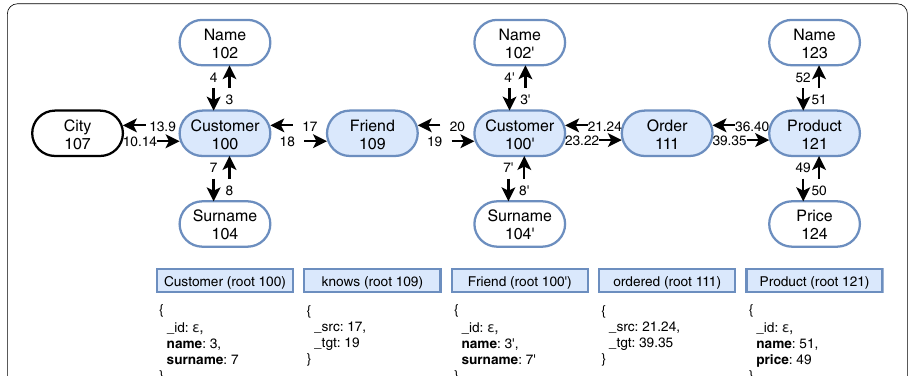
Fig. 15 Projection of the result corresponding to the graph pattern Customer Product and its mapping to the graph